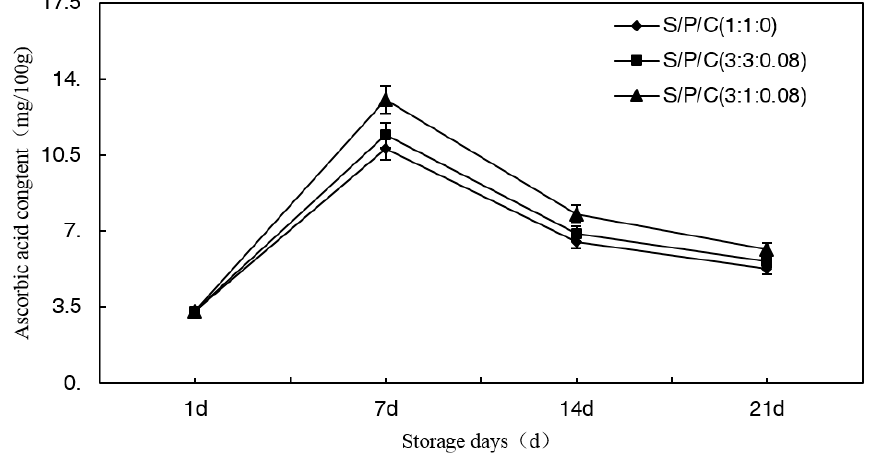
Figure 7. Effect of starch/polyvinyl alcohol/citric acid ternary blend functional food packaging films on ascorbic acid content during storage.